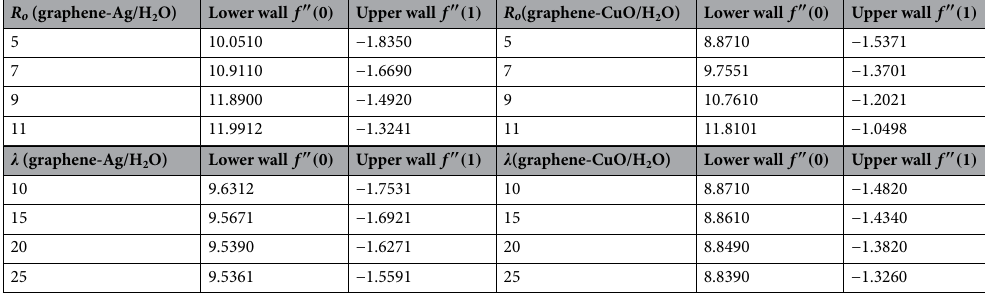
Table 2. Skin coefficient numerical values for rotational R o and porosity parameters (cid:31) .